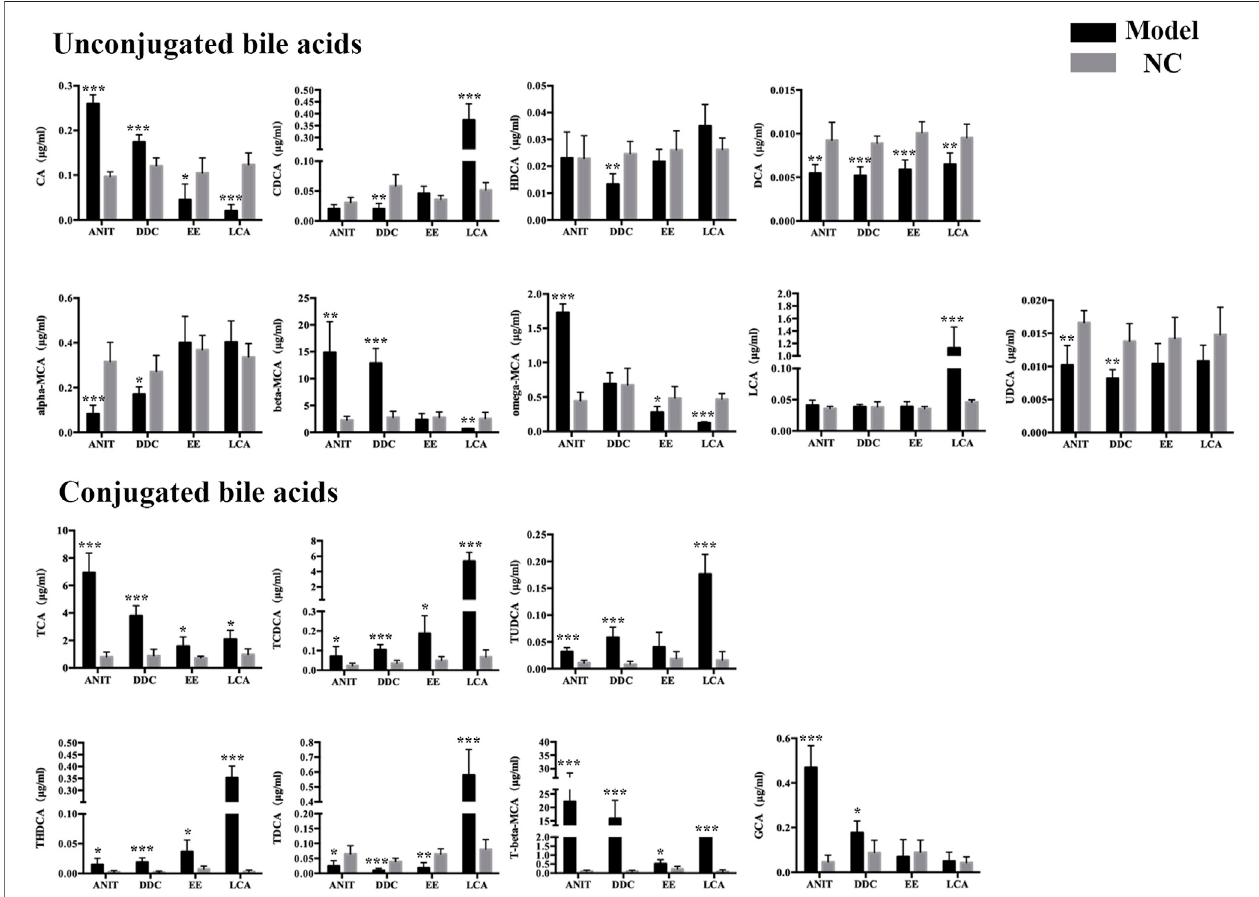
FIGURE3| ANIT,DDC,EEandLCA-induceddisorderedbileacidhomeostasisinmice.Dataarethemean±S.D.(n=5).* p < 0.05versusControl,** p < 0.01versus Control, *** p < 0.001 versus Control.